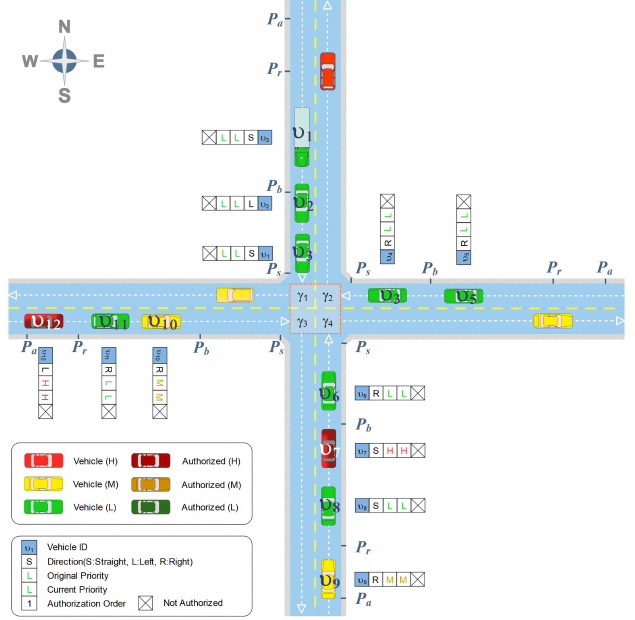
Figure 5. A Traffic